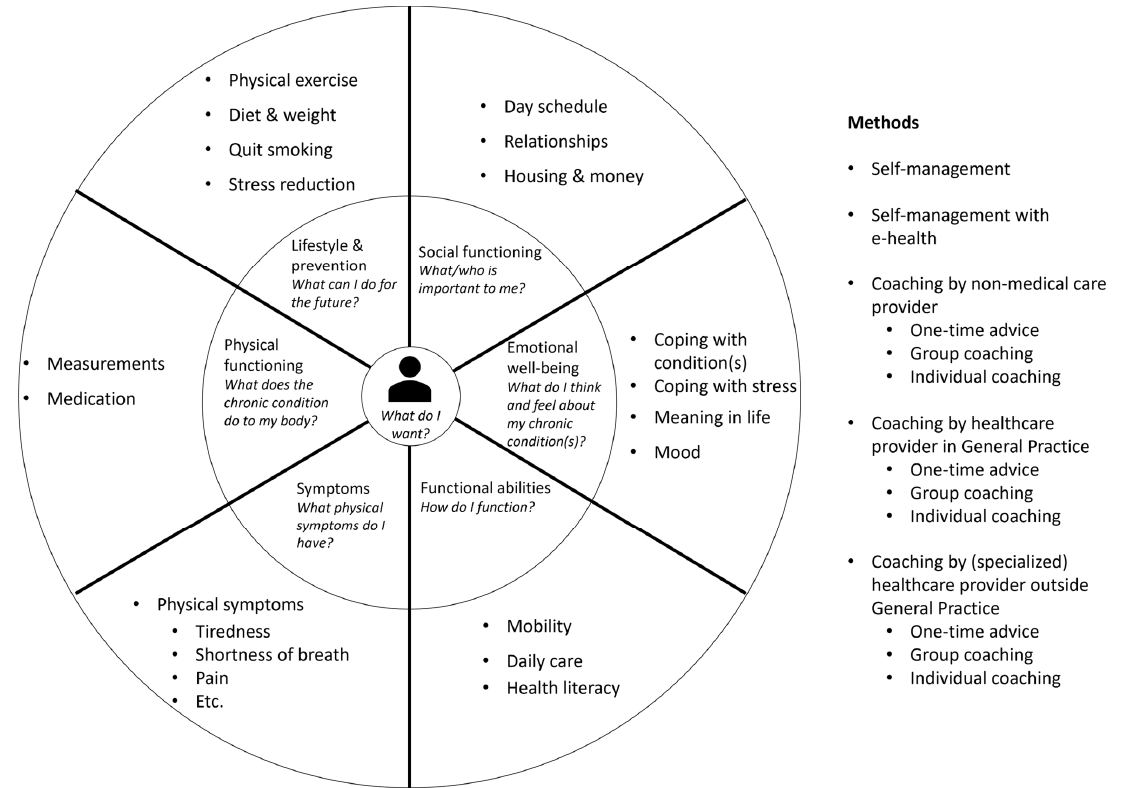
Figure 3. Final intervention model of the Person-Centred and Integrated Care (PC-IC) approach for use in daily practice. This version was adapted from a draft version after the comments of stakeholders in Phases 2 to 4 had been processed. Int. J. Environ. Res. Public Health 2023 , 20 , x FOR PEER REVIEW